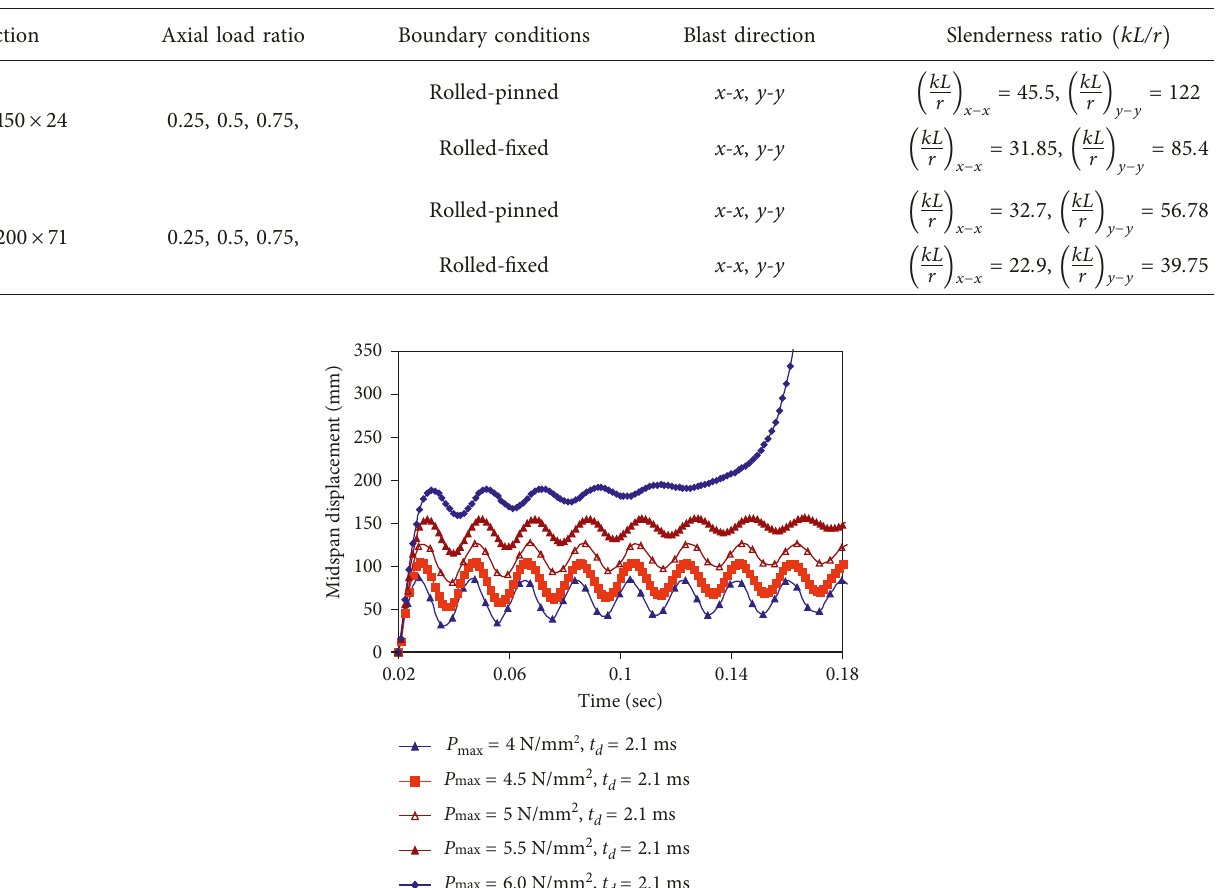
24 subjected to different values of blast ×